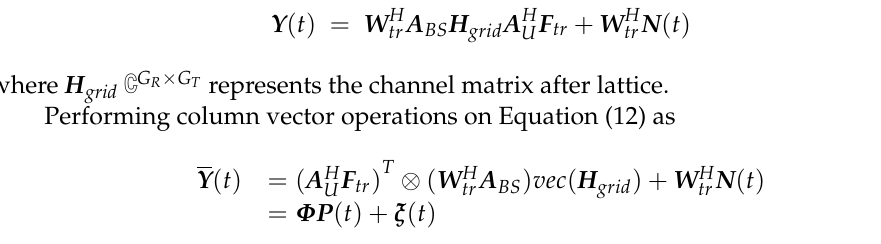
Figure 1. Adopted dynamic hybrid precoding structure.